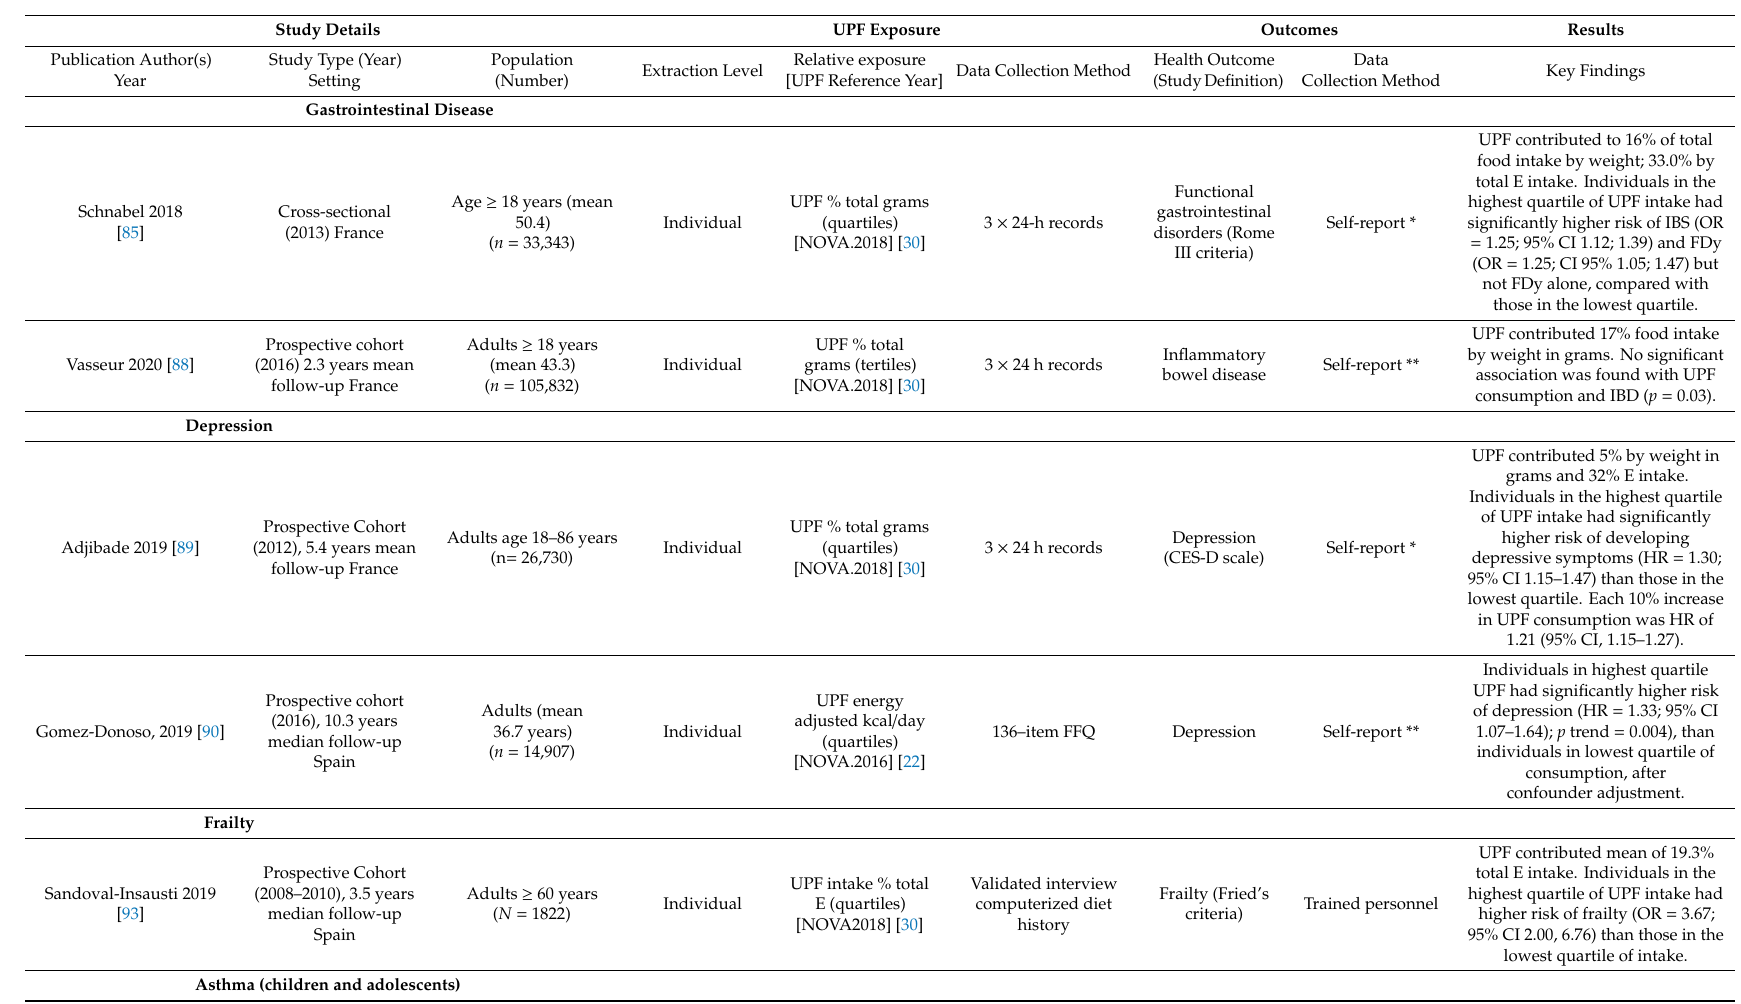
Table 5. Disorders and conditions as